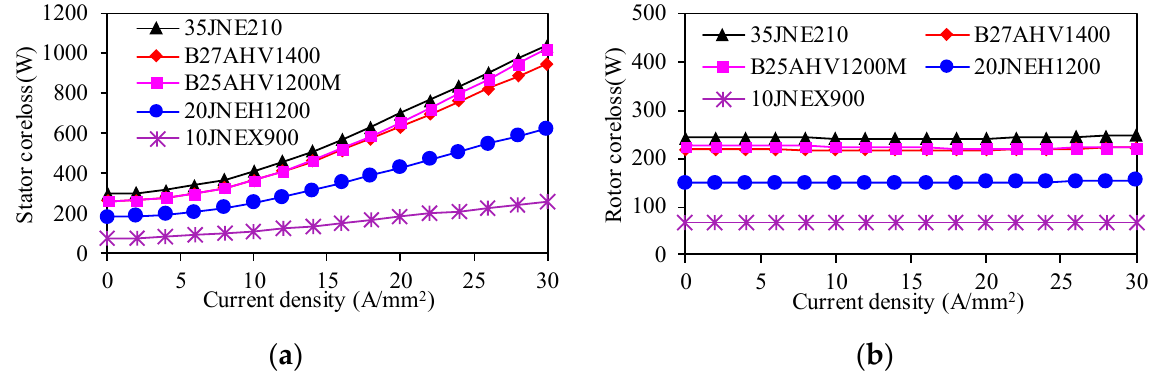
Figure 5. Effect of soft iron materials on core loss. ( a ) Stator core loss and ( b ) rotor core loss.